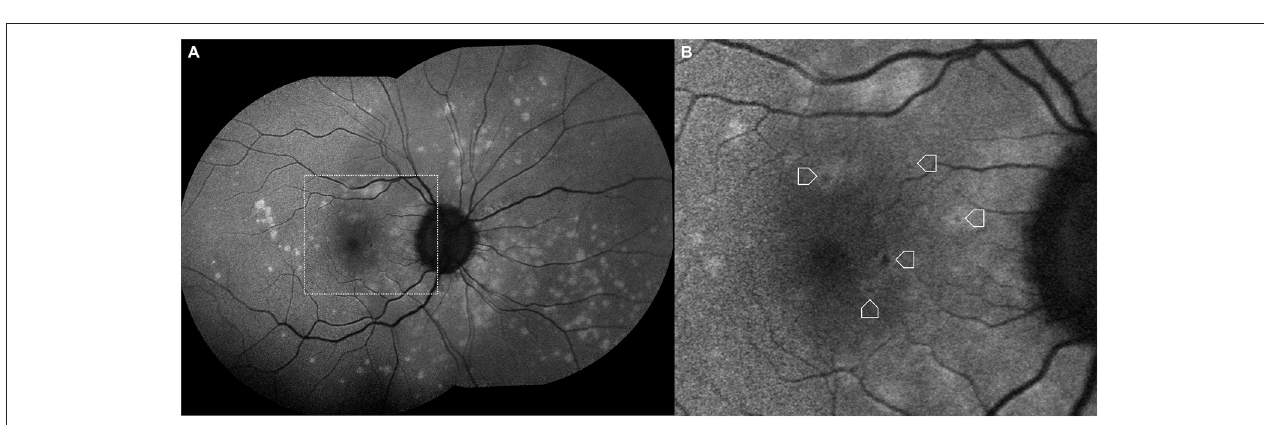
FIGURE 5 | (A) Fundus autofluorescence image in a case of acute multifocal choroiditis showing hyperautofluorescence due to unmasking secondary to photoreceptor disruption. (B) Referenced detail revealing diffuse zonal hyperautofluorescence associated with small rounded hypoautofluorescent lesions corresponding to focal retinal pigment epithelium disruptions (arrowheads).